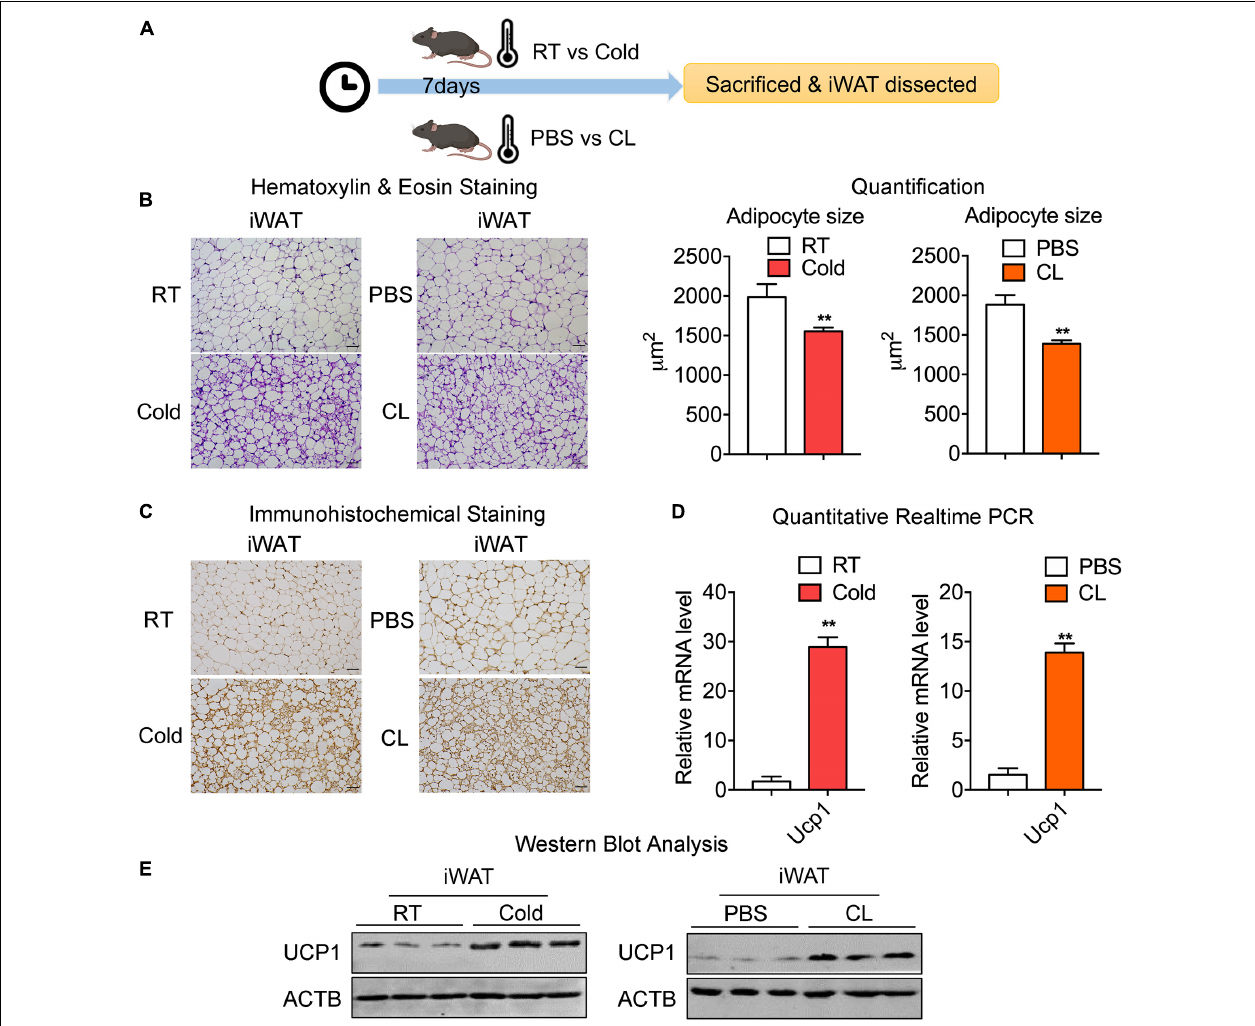
FIGURE 1 | Chronic old exposure and CL316,243 administration induce browning of white fat and thermogenic marker UCP1 levels in mice. (A) Schematic illustration of the browning of white fat induced by 7-day cold exposure or β -adrenergic agonist CL316,243 (CL) administration. (B) Representative H&E staining of adipocyte size quantification from iWAT of mice treated with RT or cold and PBS or CL. Scale bars: 50 µ m. (C–E) Representative immunohistochemical images of UCP1 staining (C) , mRNA (D) , and protein levels of UCP1 (E) in iWAT from mice treated with RT or cold and PBS or CL. Scale bars: 50 µ m. N = 6 per group. Data are presented as mean ± SEM and ** P < 0.01 compared to control